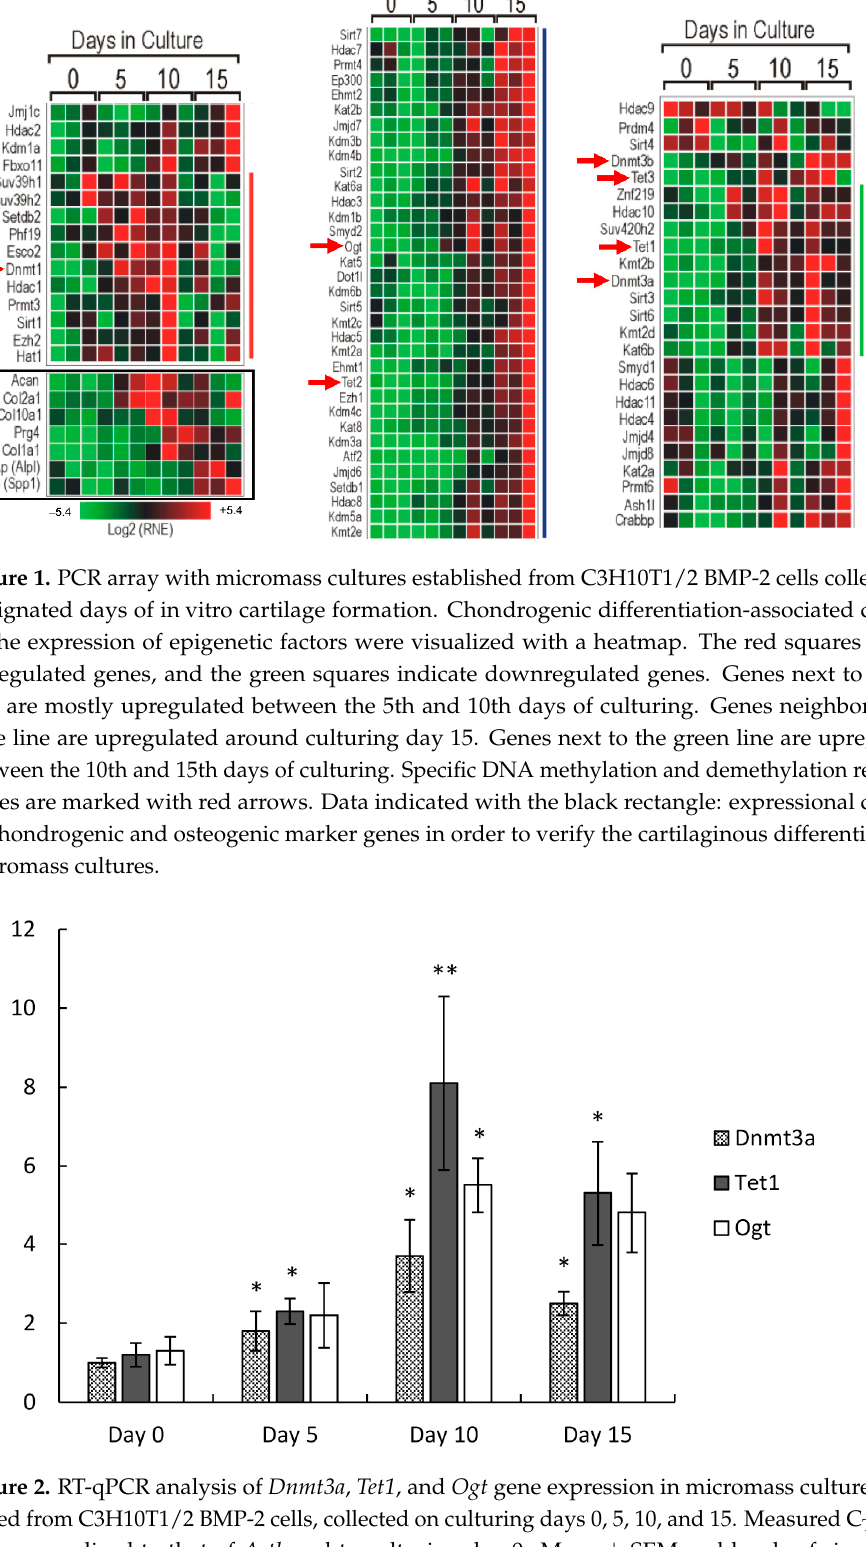
Figure 2. RT-qPCR analysis of Dnmt3a , Tet1 , and Ogt gene expression in micromass cultures estab- lished from C3H10T1/2 BMP-2 cells, collected on culturing days 0, 5, 10, and 15. Measured C T values were normalized to that of Actb and to culturing day 0. Mean ± SEM and levels of significance between consecutive culturing days (* p ˂ 0.05, ** p ˂ 0.01) are indicated. One-Way ANOVA with Tukey HSD was employed for evaluating significance. Representative results out of 3 independent experiments (biological replicates) showing similar trends of changes.